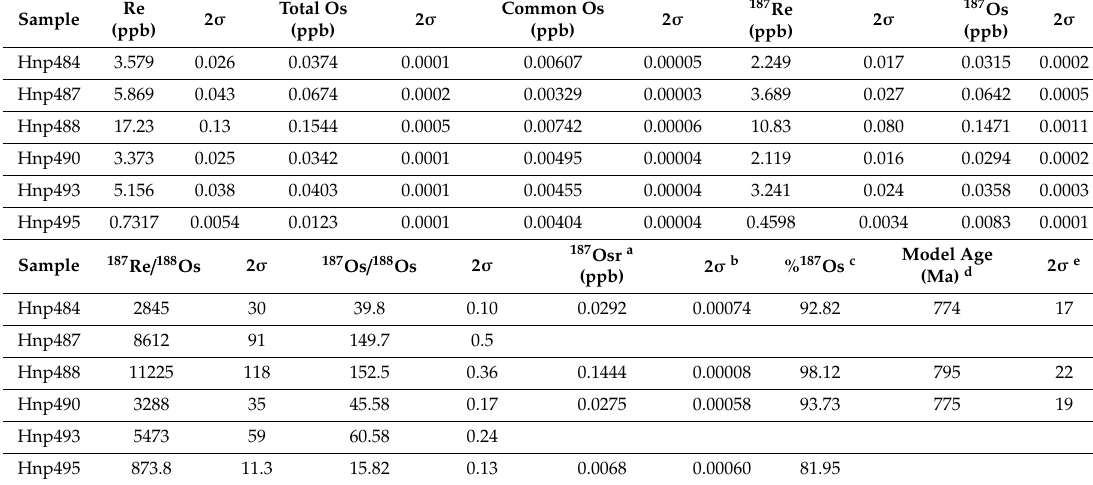
Table 3. Re-Os isotope data for chalcopyrite from vein-type ores in this study.